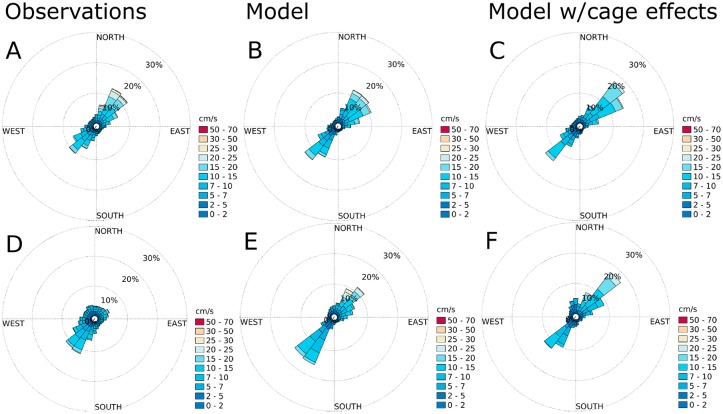
Current roses for ADCP5 (Fig 5) at 10 m depth.A: observations for August-October, 2015. B: simulation results without cage effects for August-October, 2015. C: simulation results with cage effects for August-October, 2015. D: observations for May-June, 2016. E: simulation results without cage effects for May-June, 2016. F: simulation results with cage effects for May-June, 2016. The colors indicate current speed. Each sector spans 15°.